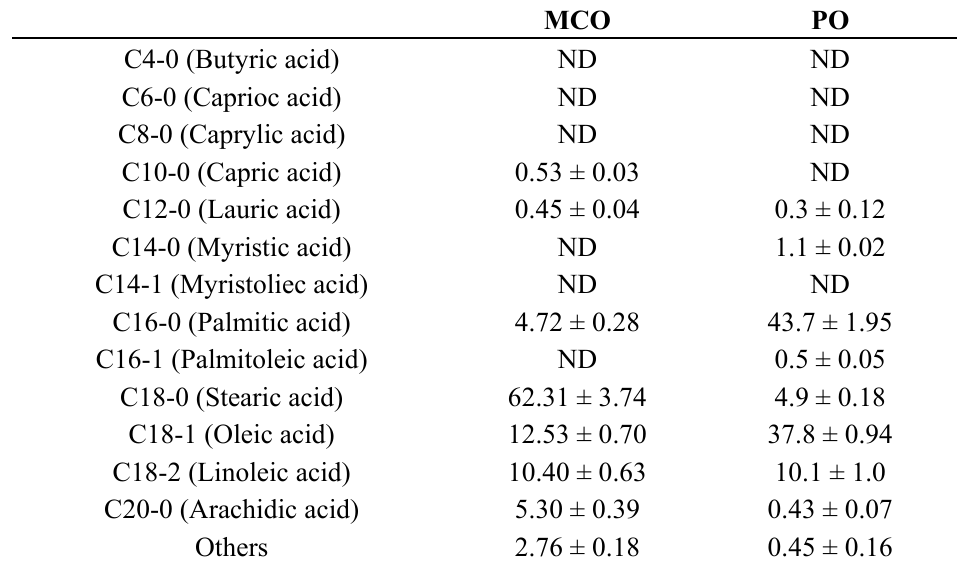
Table 1. Fatty acid composition of oil from seeds of Momordica charantia (MCOP) and palm oil (PO,